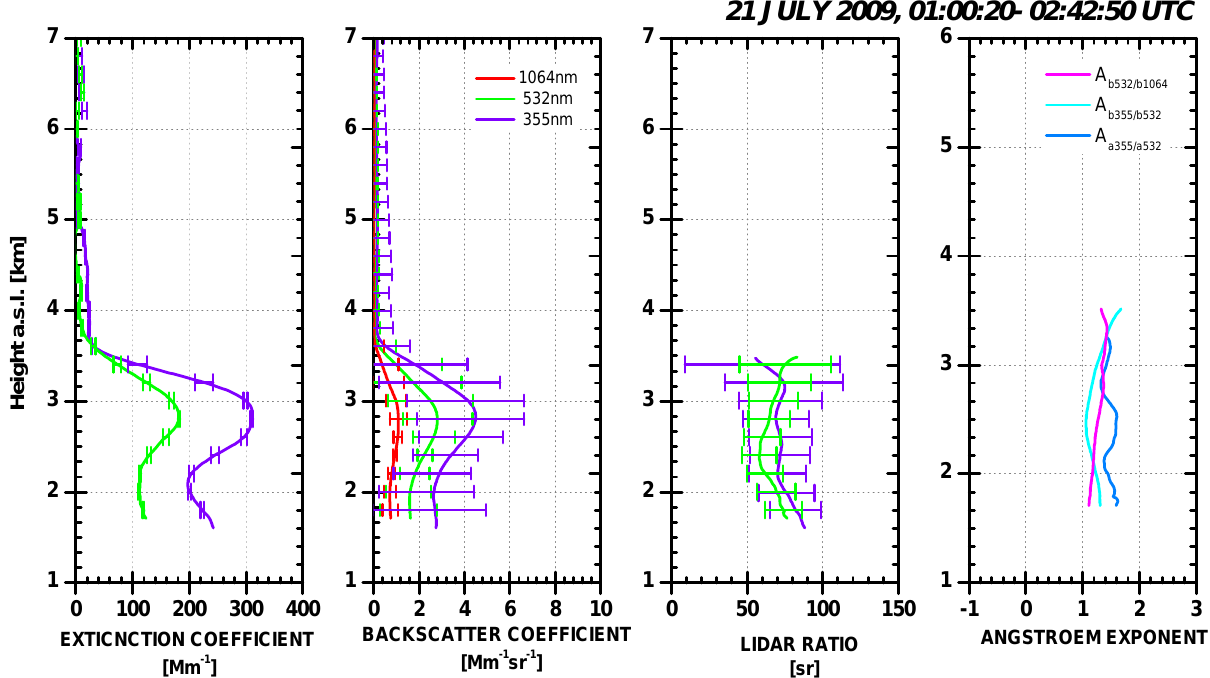
Fig. 4. Vertical profiles of the aerosol optical parameters (extinction and backscatter coefficients, lidar ratio, ˚Angstr¨om exponent) retrieved from Raman lidar measurements on 21 July 2009